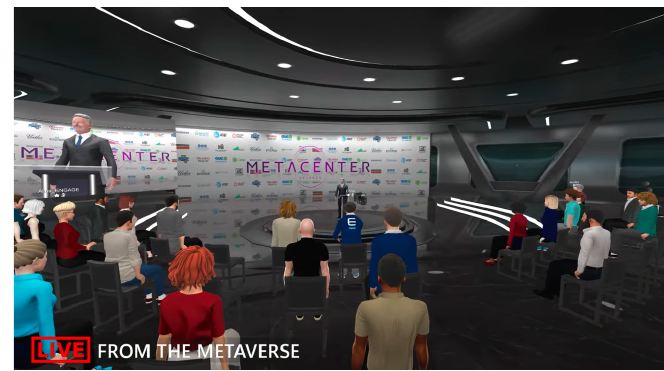
Figure 15: Mayor of Orlando in the metaverse